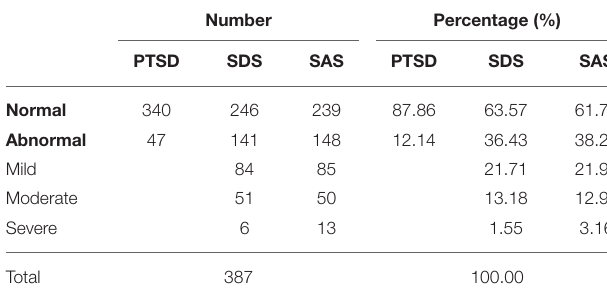
TABLE 4 | Numbers and percentages of survivors in PTSD, SDS, and